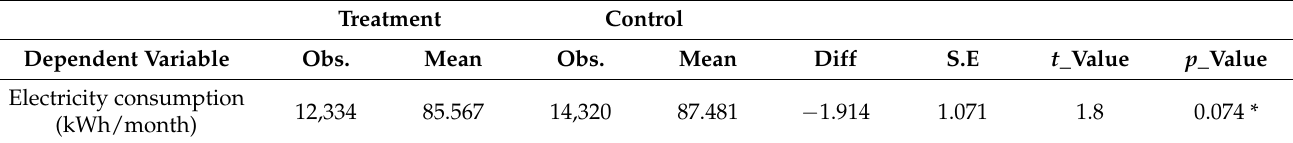
Table 4. Baseline comparison between the